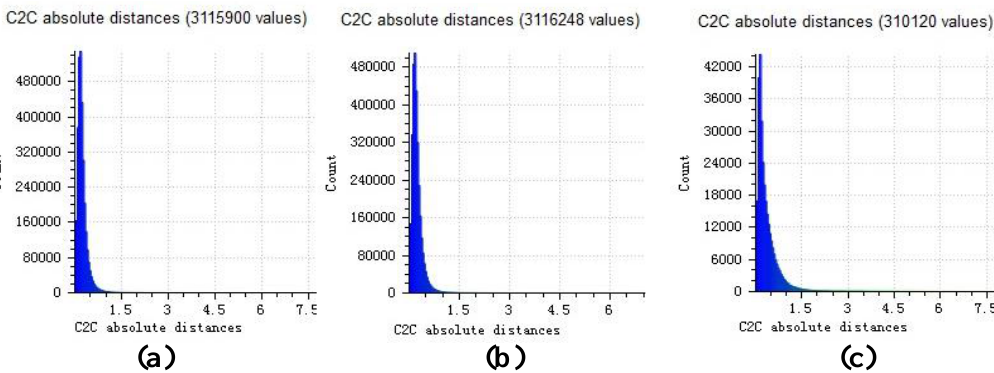
Figure 12. ( a ) Distance histogram of our result; ( b ) Distance histogram of openMVG + openMVS; ( c ) Distance histogram of MicMac.